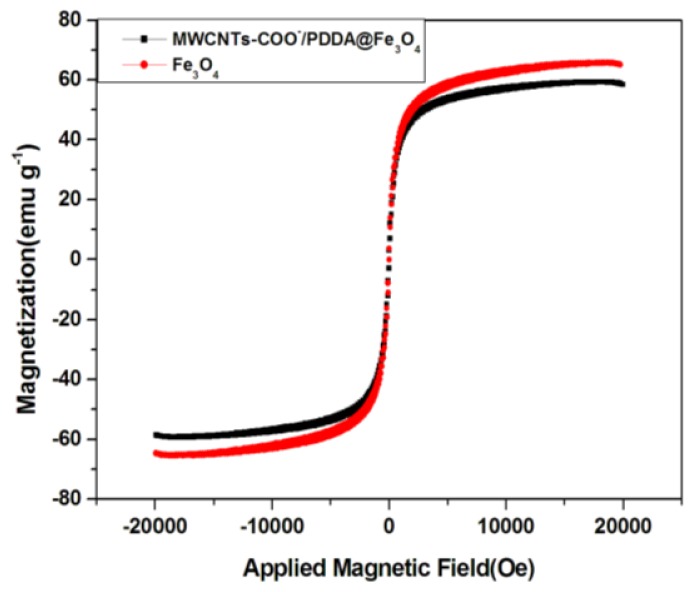
Vibrating sample magnetometer (VSM) supermagnetization curves of Fe3O4 and MWCNTs-COO−/PDDA@Fe3O4.